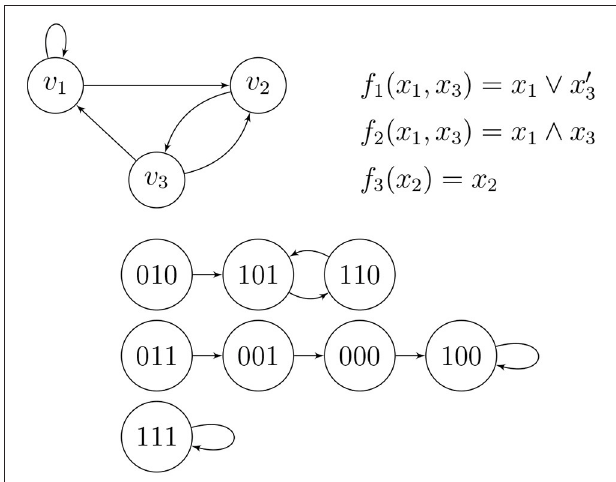
FIGURE 5 | Two equivalent pictures of a gene regulatory network